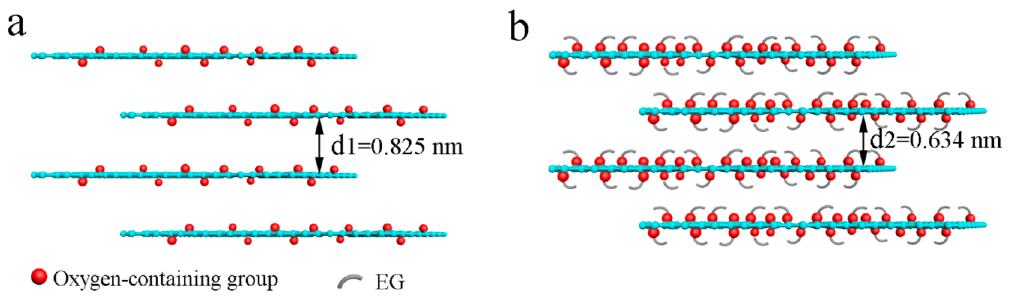
Figure 8. Schematic diagram of EG modified GO.